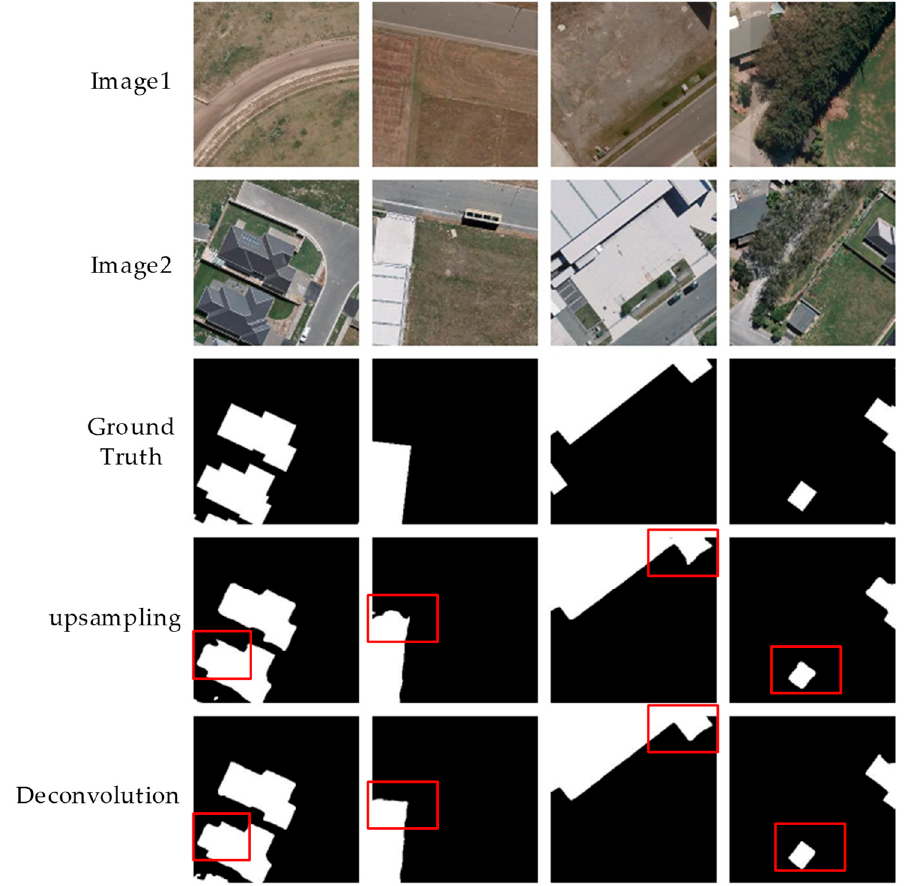
Figure 7. Illustrations of BuCD results for networks with different decoders used on the WHUCD dataset. From the red boxes, we can find that the network with the decoder using deconvolutional operations illustrates more precise boundaries compared with one with the decoder using the up- sampling